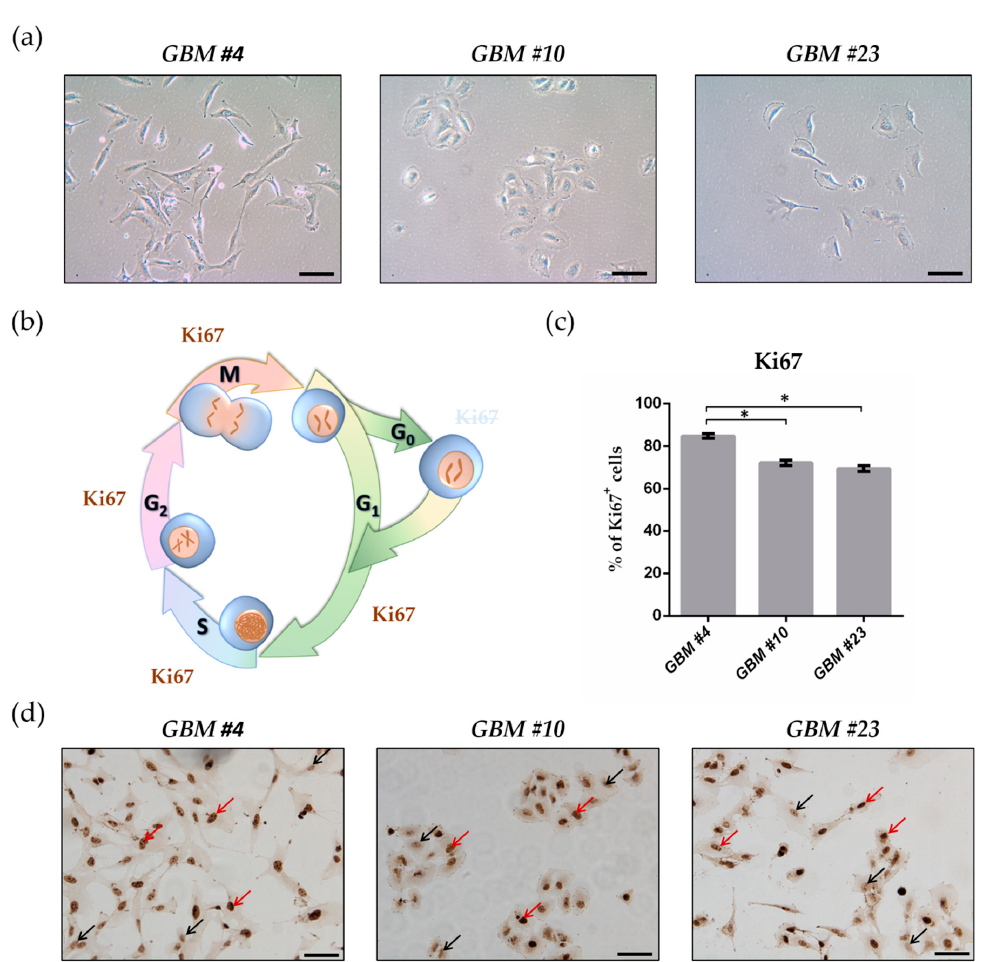
Figure 1. Morphological features and Ki67 immunoreaction of patient-derived glioblastoma (GBM) cells. ( a ) Representative light microscope images of the cell morphology of GBM #4 , GBM #10 , and GBM #23 . Scale bar = 50 µm. ( b ) Schematic overview showing the presence of Ki67 during the cell cycle. Ki67 is located in the nucleus and is detectable during the whole cell cycle (G 1 -, S-, G 2 -, and M-phase), except for the G 0 -phase. ( c ) Graph indicates the percentage of GBM cells showing Ki67 positivity (Ki67 + ). Patient-derived GBM cells exhibited different and high numbers of Ki67-labbelled cells. Their percentage was as follows: 84.73% ± 1.11% ( GBM #4 , n = 34), 72.12% ± 1.18% ( GBM #10 , n = 32), and 69.42% ± 1.44% ( GBM #23 , n = 22). Data are means ± SEM of all untreated control groups of this study. Significance was chosen for p < 0.05. The asterisk denotes significant results regarding the respective measurement indicated with the bar. ( d ) Representative images of Ki67-stained GBM #4 , GBM #10 , and GBM #23 . Brown staining represents Ki67 + cells (red arrows) and blue staining Ki67 - cells (black arrows). Nuclei were counterstained using hematoxylin. The number of values is represented by n . Scale bar = 75 µm.